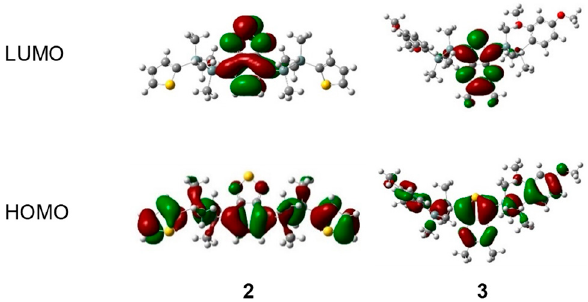
Figure 4. Electron density distribution of frontier molecular orbitals of representative compounds 2 and 3 , calculated at the B3LYP/6-31G (d, p) level.